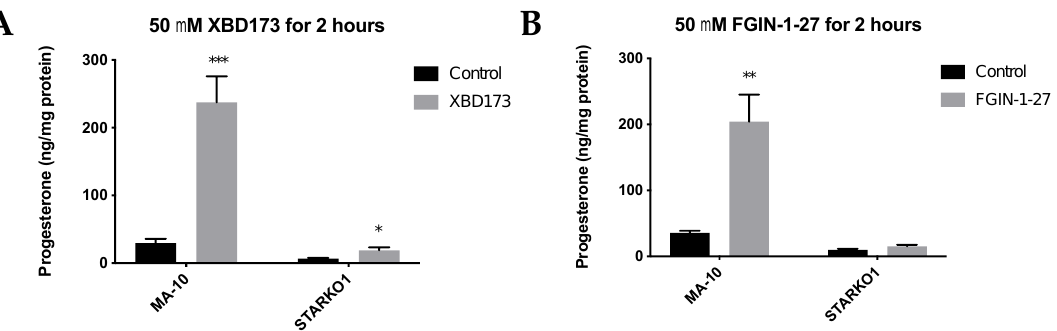
Figure 4. Progesterone production by wild-type MA-10 and STAR KO cell lines in response to TSPO drug ligands. ( A ). ELISA analyses of progesterone levels in cell media following stimulation with 50 μM XBD173 for 2 h. ( B ). ELISA analyses of progesterone levels in cell media following stimulation with 50 μM FGIN -1-27 for 2 h. Data are shown as the mean ± SEM ( n = 3). * p < 0.05; ** p < 0.01; *** p < 0.001.